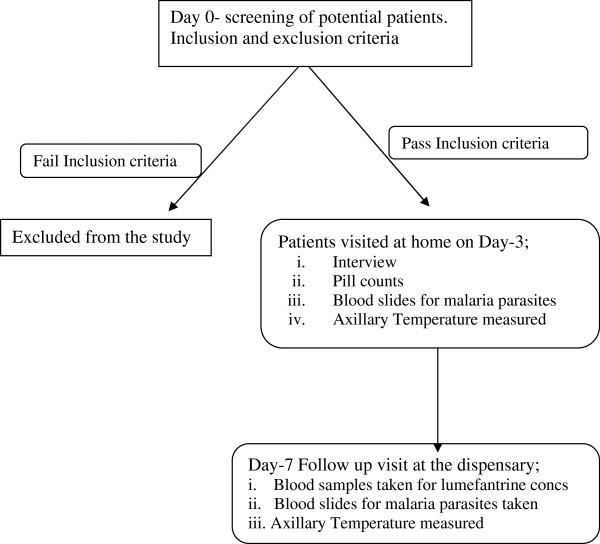
Flow chart for study procedures.